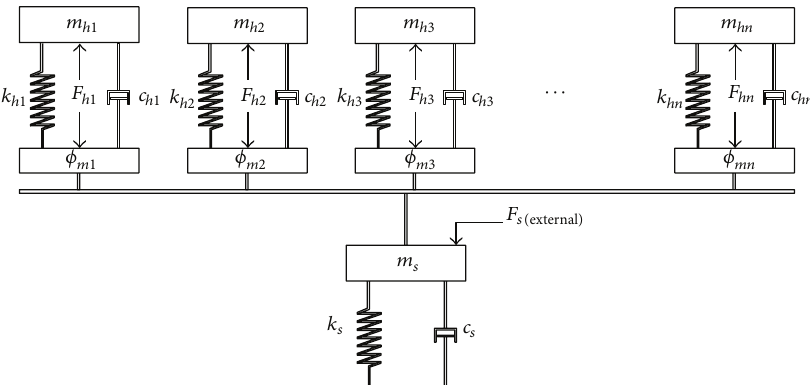
Figure 7: The mechanical model of a walking people-structure system simulated as an stationary system.